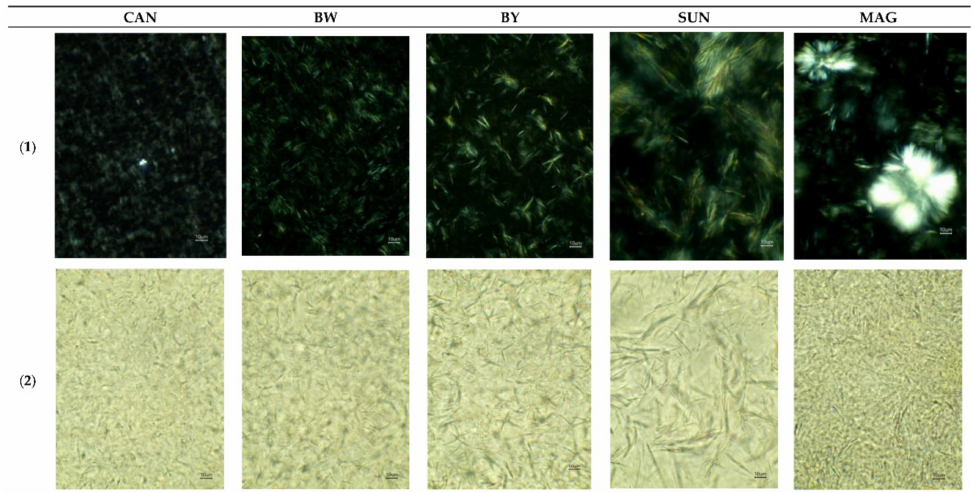
Figure 3. The microstructure of oleogels at 600 × magnification, obtained by polarization ( images at the top-1 ) and bright field ( images at the bottom-2 ) for rapeseed oil oleogel structured with 5% sunflower wax (SUN), candelilla wax (CAN), bees wax white (BW), bees wax yellow (BY), or monoacylglycerols (MAG). Taken from Kupiec et al. [66]. Copyright 2020 Creative Common Attribution